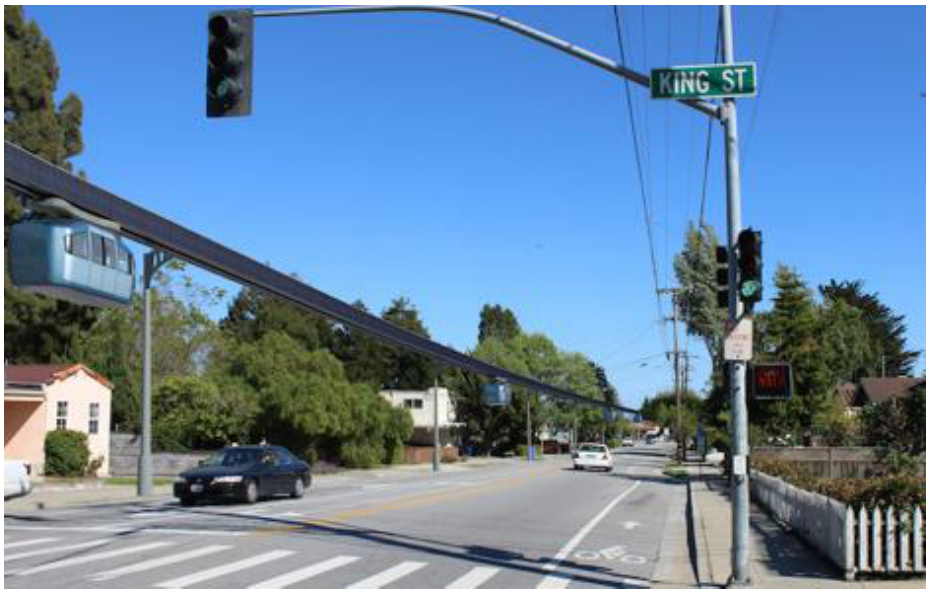
Figure 16. SANE transit (S = Solar, A = Automated, N = Nonstop, E = Elevated) [40].